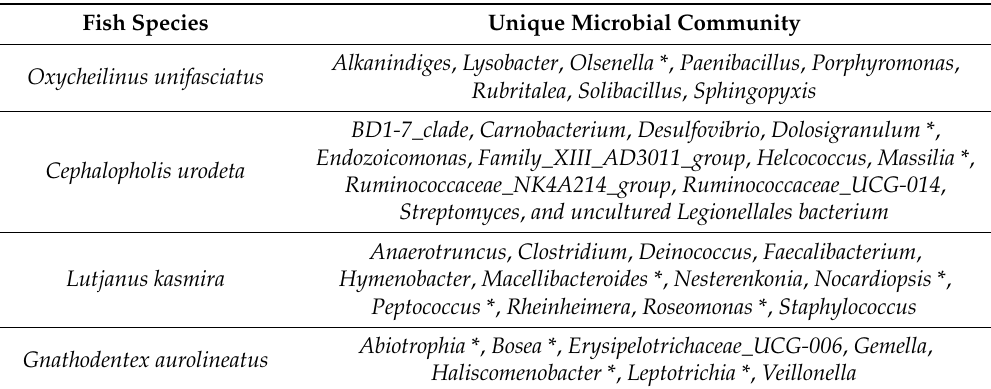
Table 2. Unique gut microbial community at genus level in four di ff erent coral reef fishes from the South China